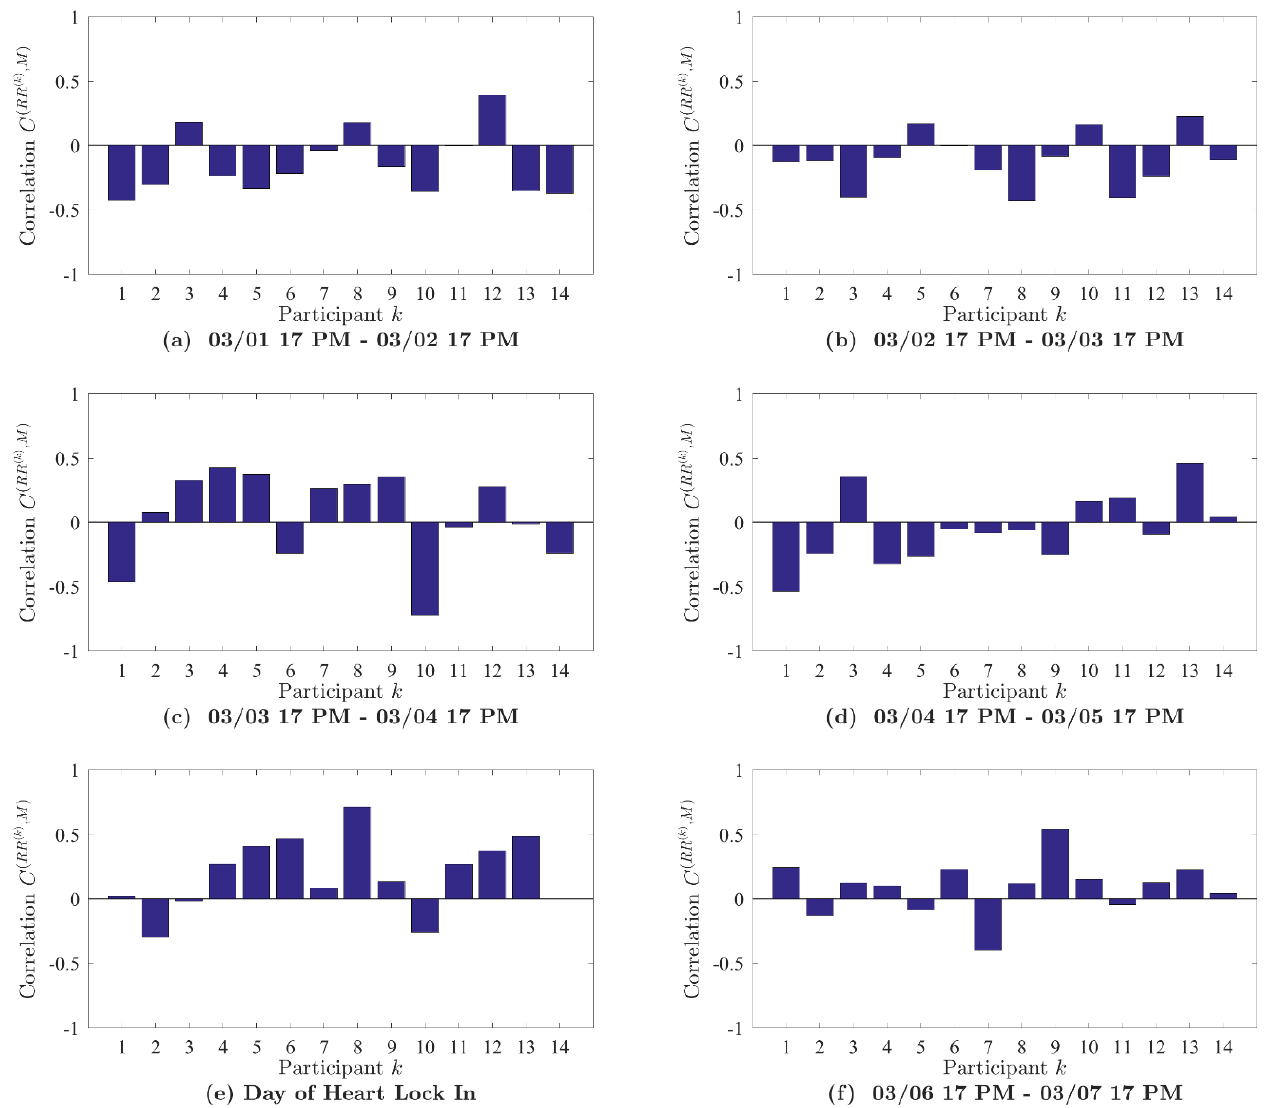
Figure A5. The results of the analysis of the LMF-HRV-synchronization for UK. Each part of the figure displays participants’ LMF-HRV-synchronization for the indicated day. Plot (e) corresponds to the day of the Heart Lock-In. Note that most of the participants’ HRV signals shifted to being positively correlated (synchronized) with LMF on the day of the Heart